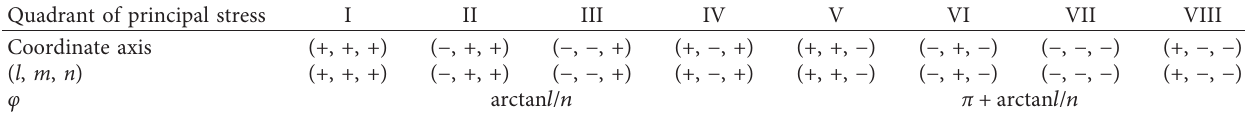
Table 6: The calculation equation of φ .